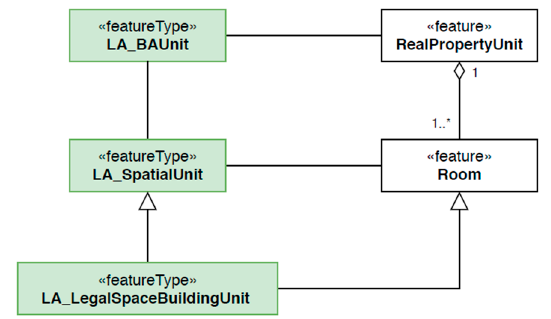
Figure 4. Linking Land Administration Domain Model (LADM) classes (green) to the data model of simulated buildings (white).